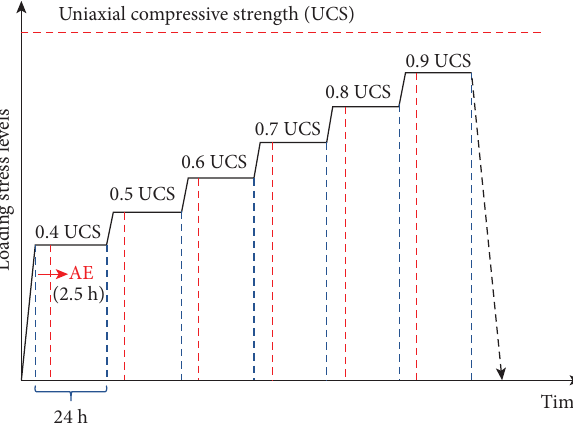
Figure 2: Te loading paths of the creep tests [21].